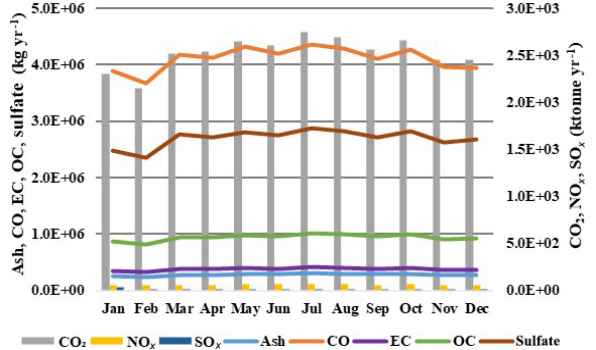
Figure 2. Monthly amounts of CO 2 , NO x , SO x (ktyr − 1 ; bars, right axis), ash, CO, EC, OC, and sulfate (kgyr − 1 ; lines, left axis) ship- ping emissions in the study domain during